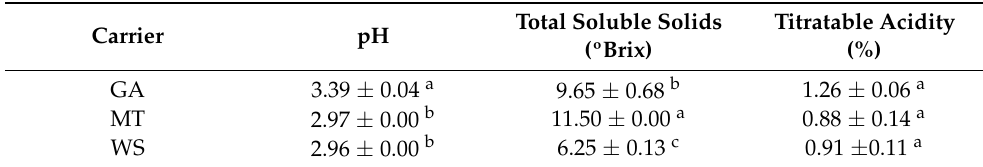
Table 2. pH, total soluble solids and titratable acidity of freeze-dried raspberry juice powders obtained with different carriers.